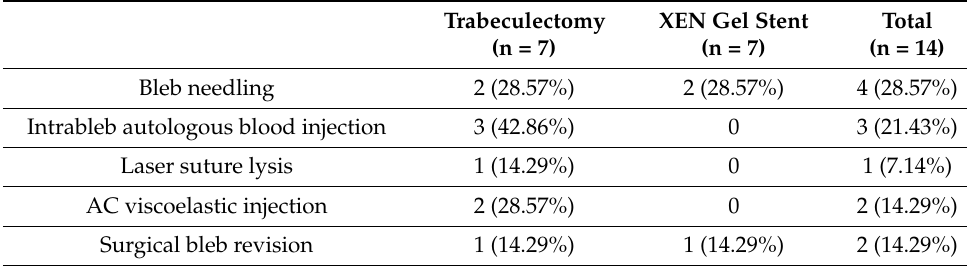
Table 4. Postoperative